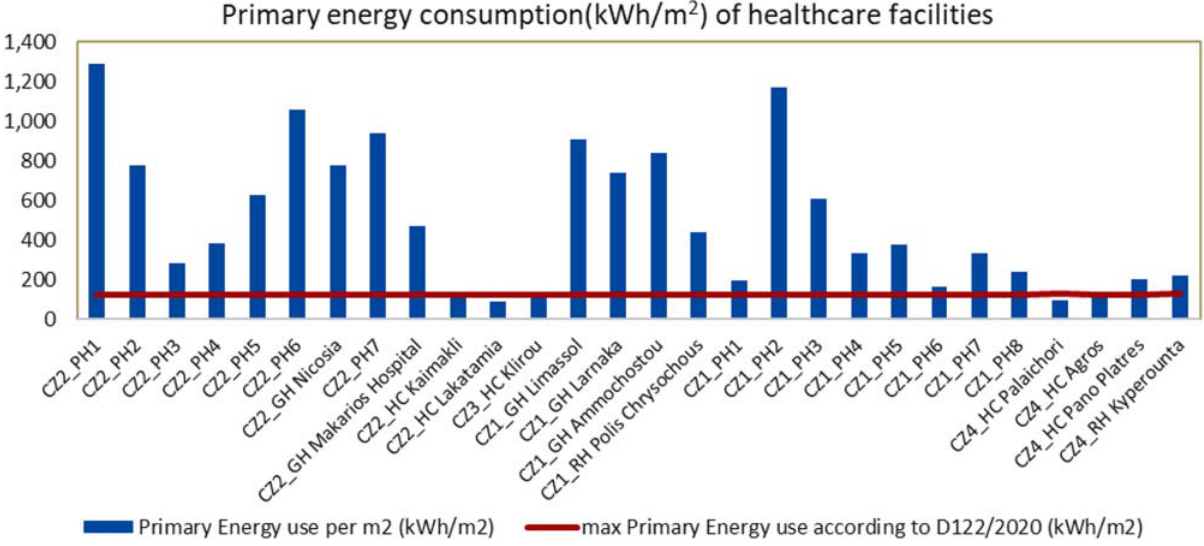
Fig. 4. Primary energy consumption (kWh/m 2 ) of the healthcare facilities compared with the national nZEB